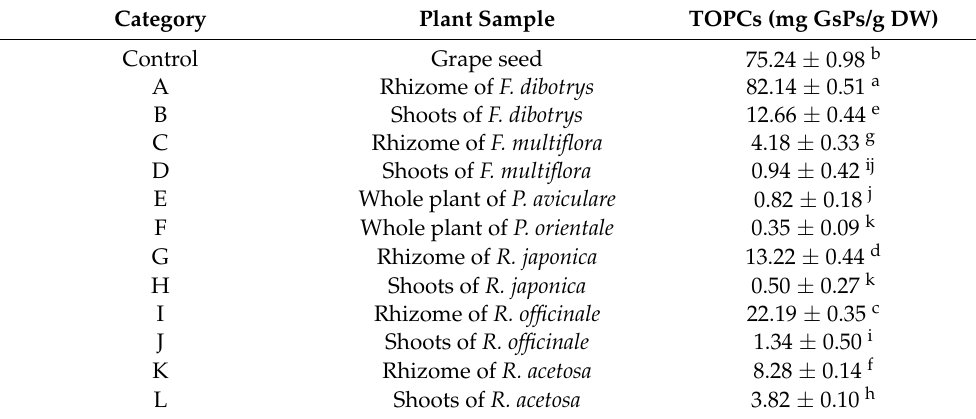
Table 1. The TOPCs of seven plant materials of the Polygonaceae family and grape seed.